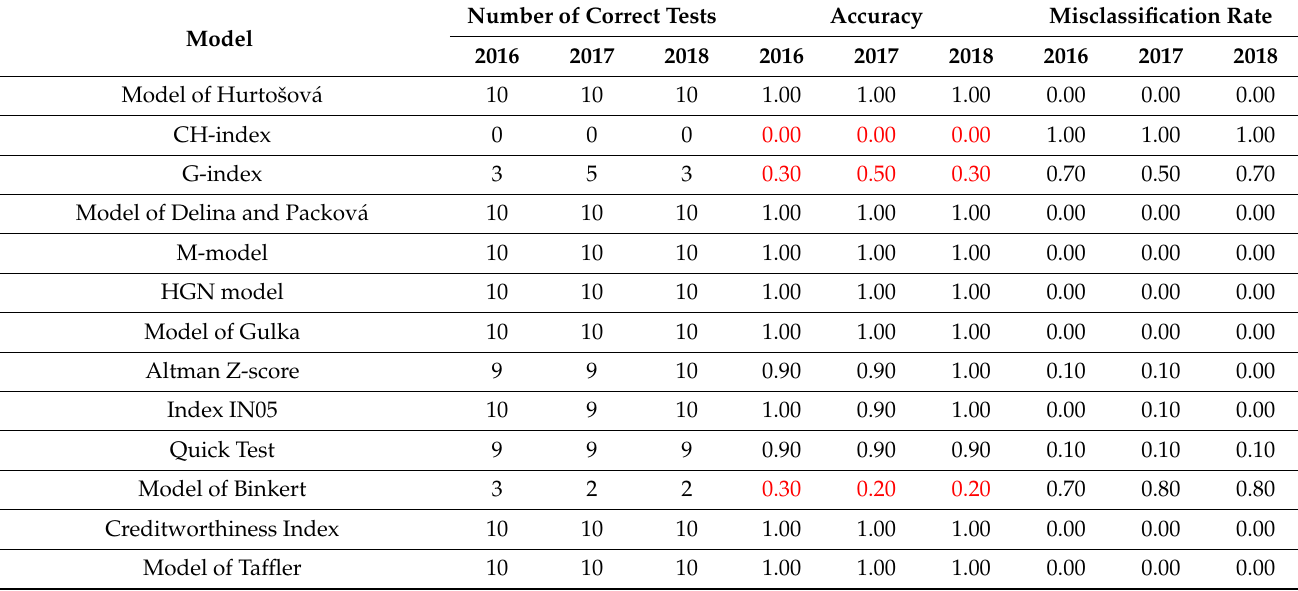
Table 6. Results of testing default prediction models on prosperous companies in retail sector in